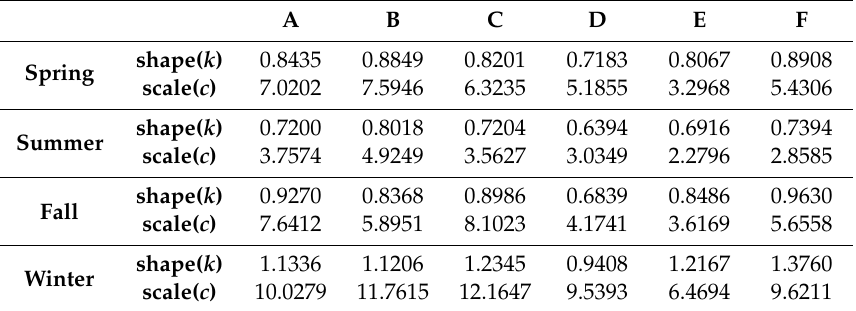
Table 6. The Weibull distribution parameters of wind power output in Jeju